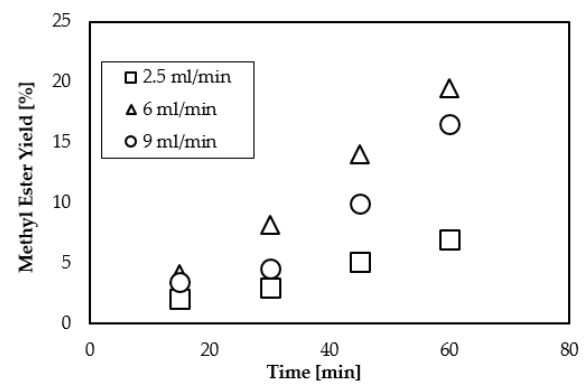
Figure 2. Effect of the triolein flow rate on the methyl ester yield at 90 °C and 5 wt% CaO.